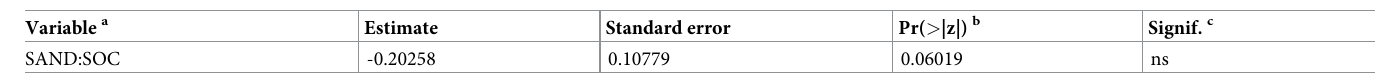
a Table 2 for the full names and units of the variables. The sign ‘:’ indicates the interaction between terms. b Pr( > |z|), probability of the z -score. c